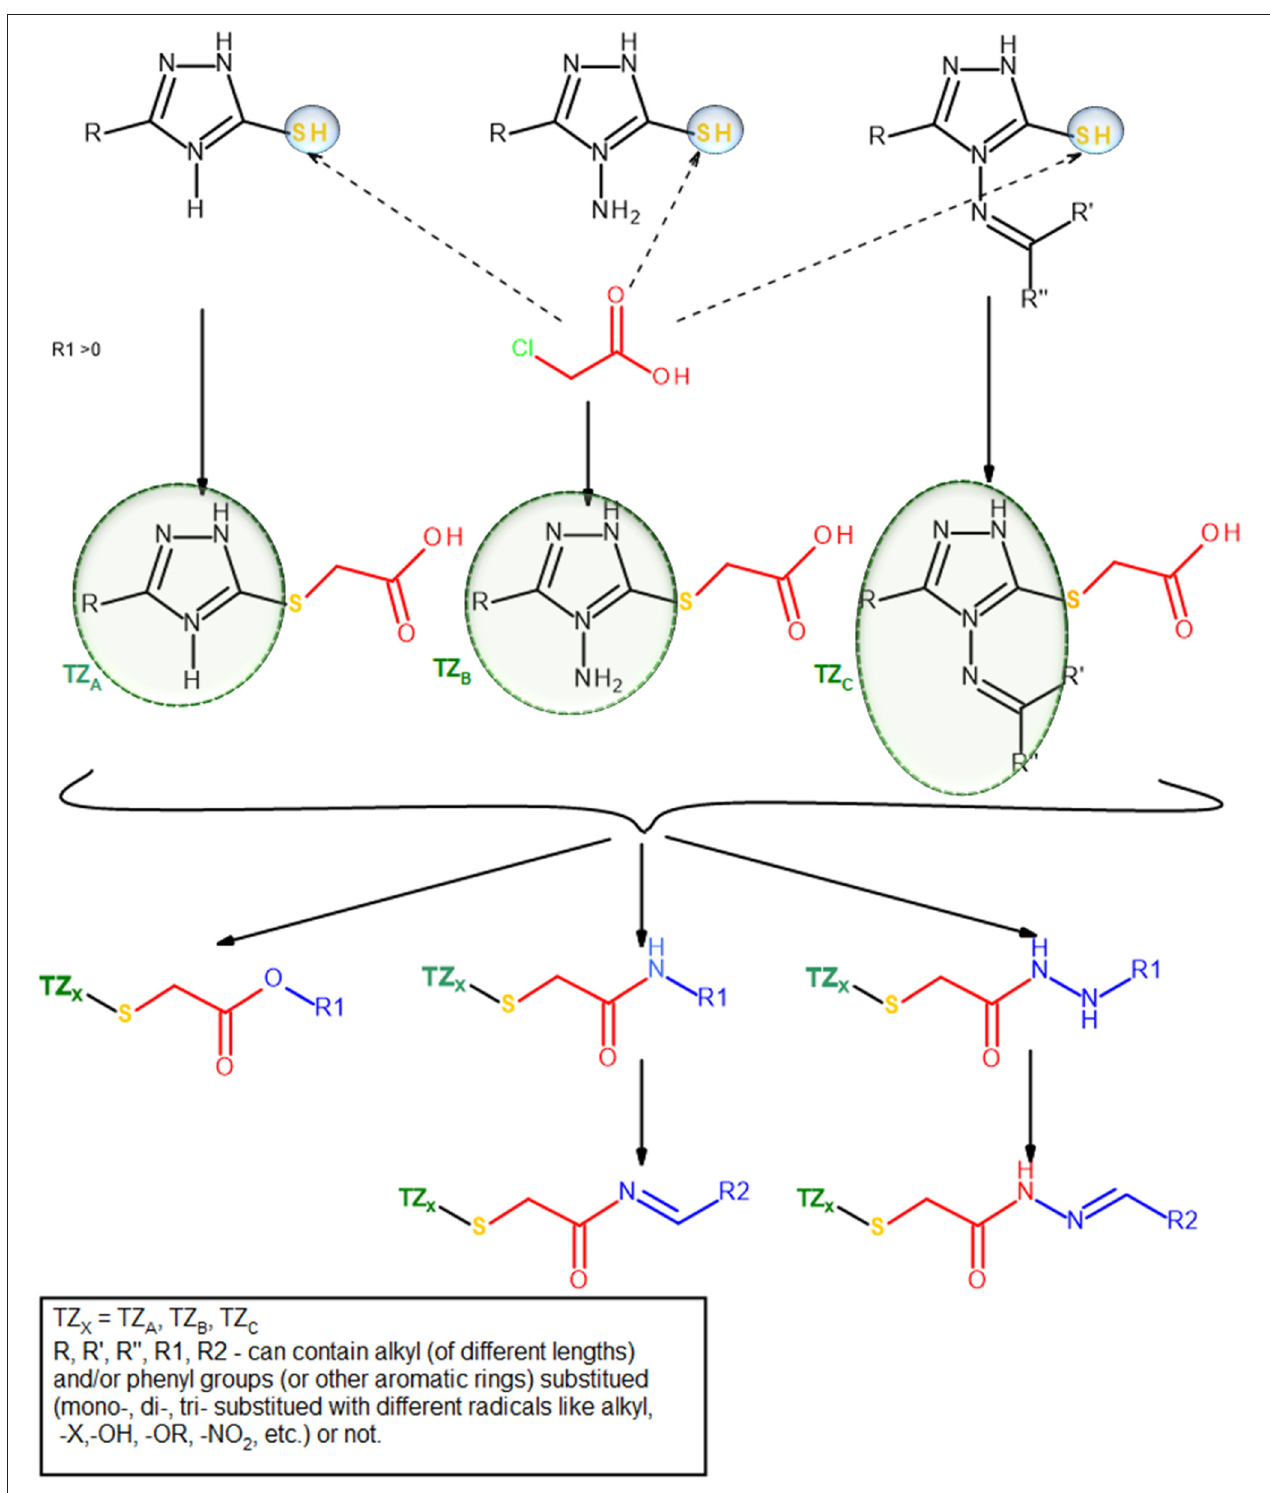
FIGURE 2 | Compound library construction